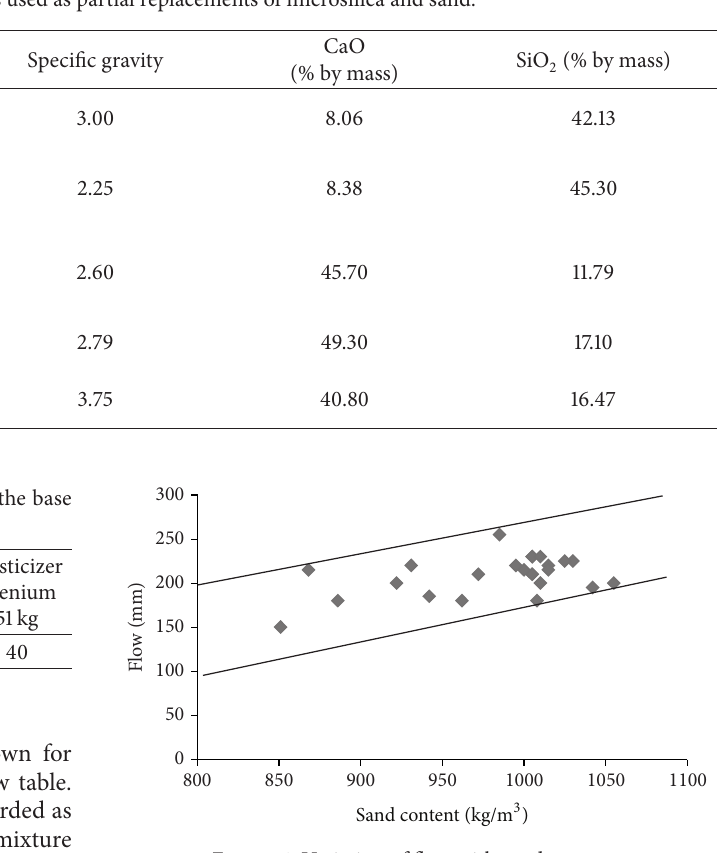
Figure 1: Variation of flow with sand content.